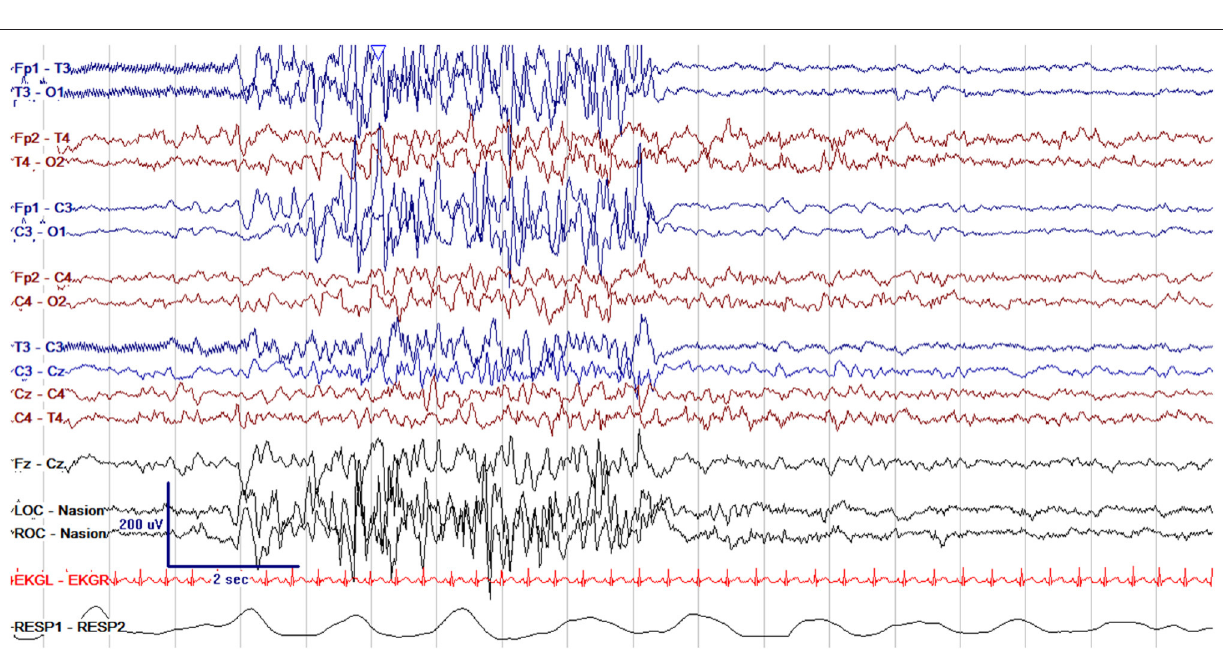
for burst suppression, 92 and 99% for low voltage, and 78 and 99% for flat tracing, however there was some variation in the definitions used for these background patterns across studies (6). The Total Body Hypothermia for Neonatal Encephalopathy Trial (TOBY) demonstrated a positive predictive value of